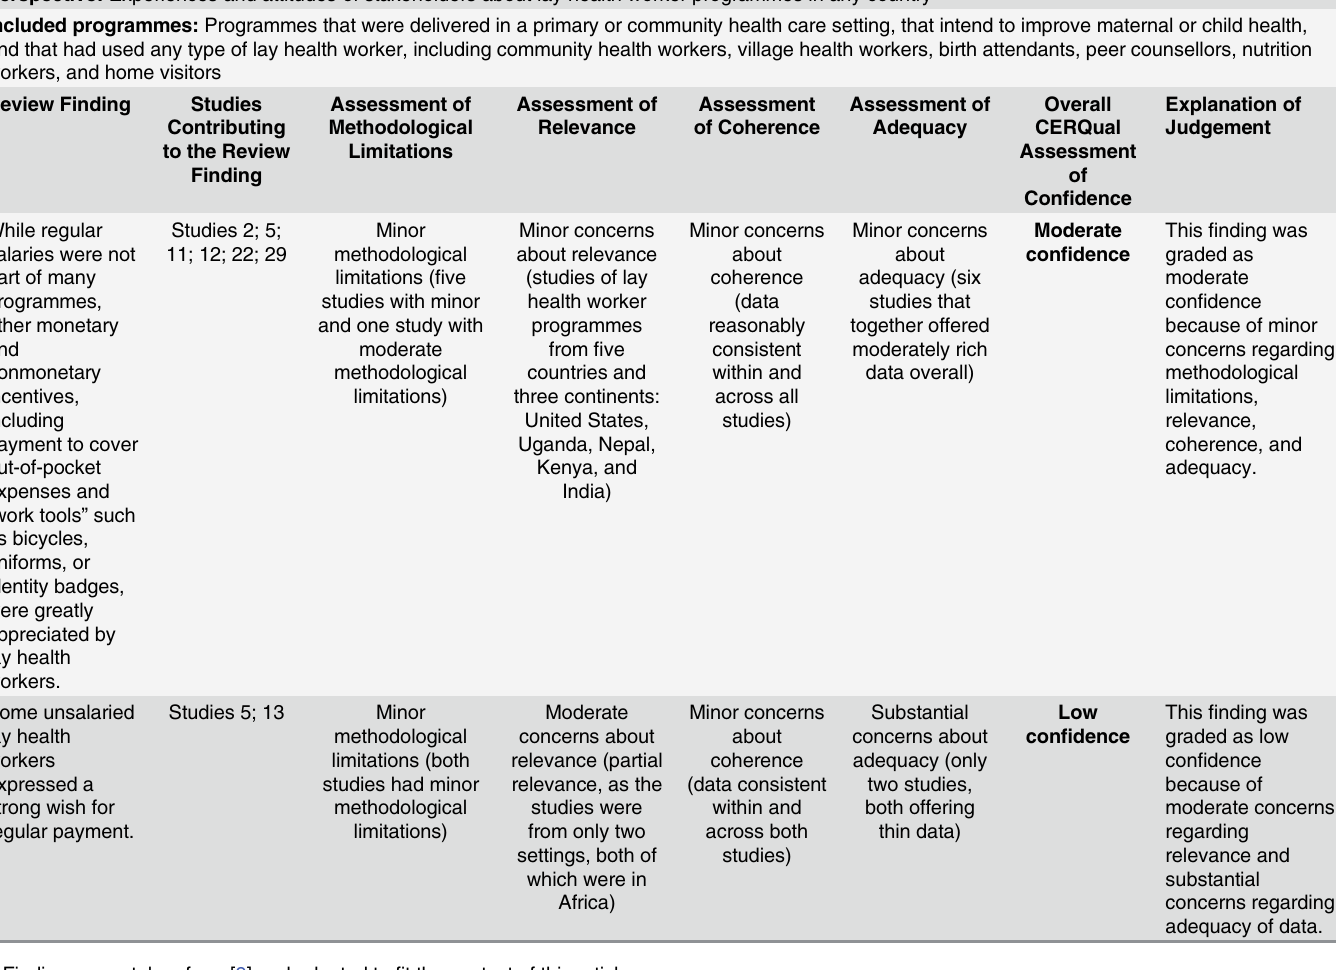
Table 2. Example of a CERQual Qualitative Evidence Profile * #